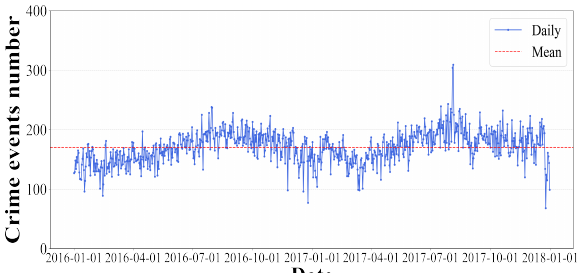
Figure 4. The daily number of theft crimes from January 1, 2016 to December 31,